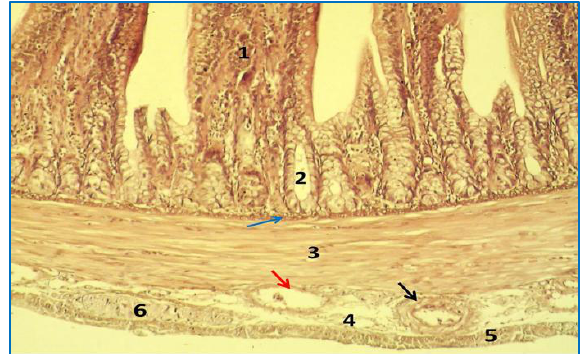
Figure, 7: Section of duodenum (Kestrel) shows: Villus (1), epithelial crypts (2), tunica muscularis inner layer (3), tunica muscularis outer layer (4), tunica serosa (5), aurbach plexuses (6), submucosa (blue arrow), small artery (Black arrow) and small vein (Red arrow). H and E stain,